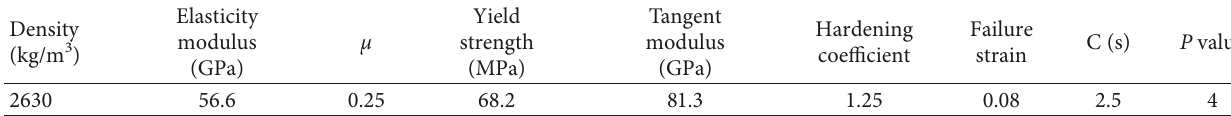
Table 5: Rock mechanical parameters.